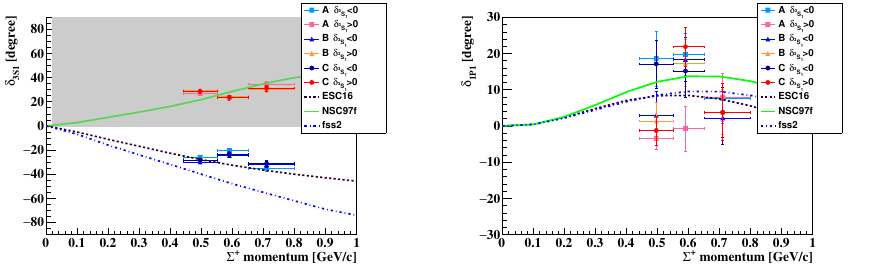
Figure 3. Obtained phase shifts δ 3 and δ 1 as a function of the incident Σ + momentum. A, B, and C S 1 P 1 in the legend correspond to the examined sets of fi xed parameters. The black dashed, green solid, and blue dotted lines represent the theoretical calculations of ESC16, NSC97f, and fss2,